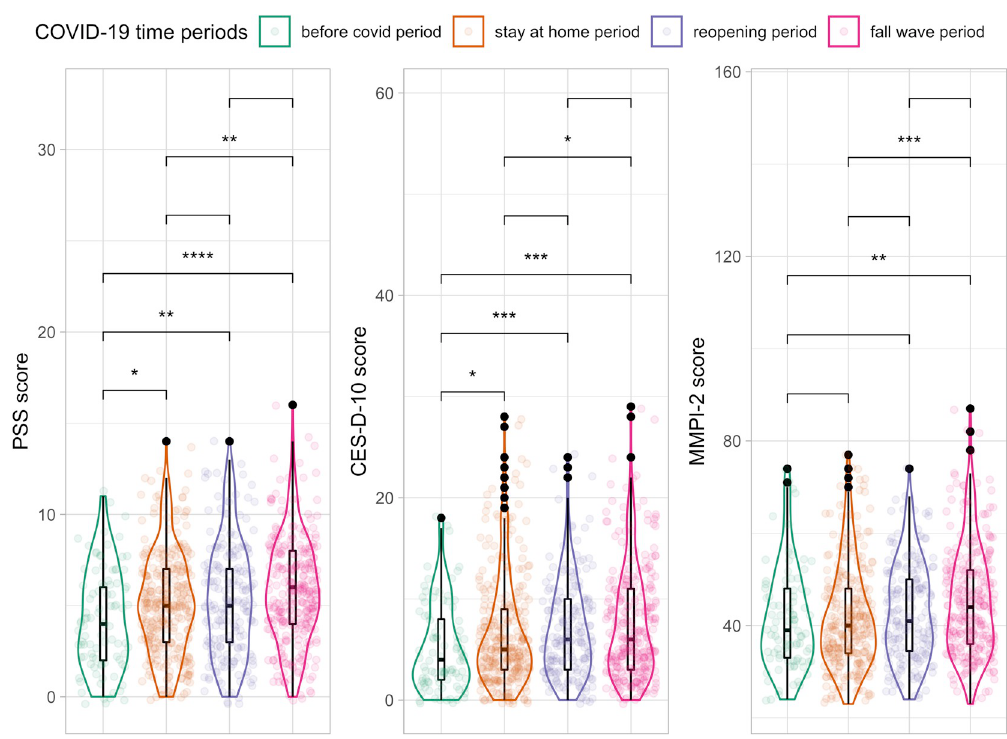
Fig 2. Distributions for PSS-4, CES-D-10 depression, and MMPI-2 anxiety scores across COVID time periods N = 911. Significant differences between medians by time period for a given mental health metric was determined using a pairwise Wilcox Test. � : p < = 0.05, �� : p < = 0.01, ��� : p < = 0.001, ���� : p < =